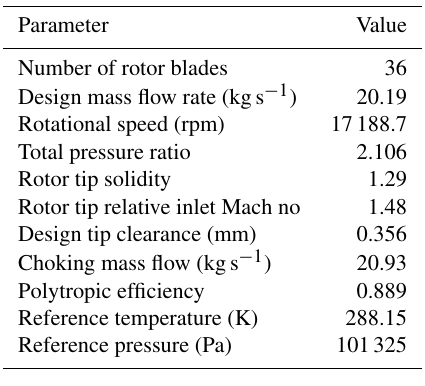
Table 1. Design specification of Rotor 37 (1998).